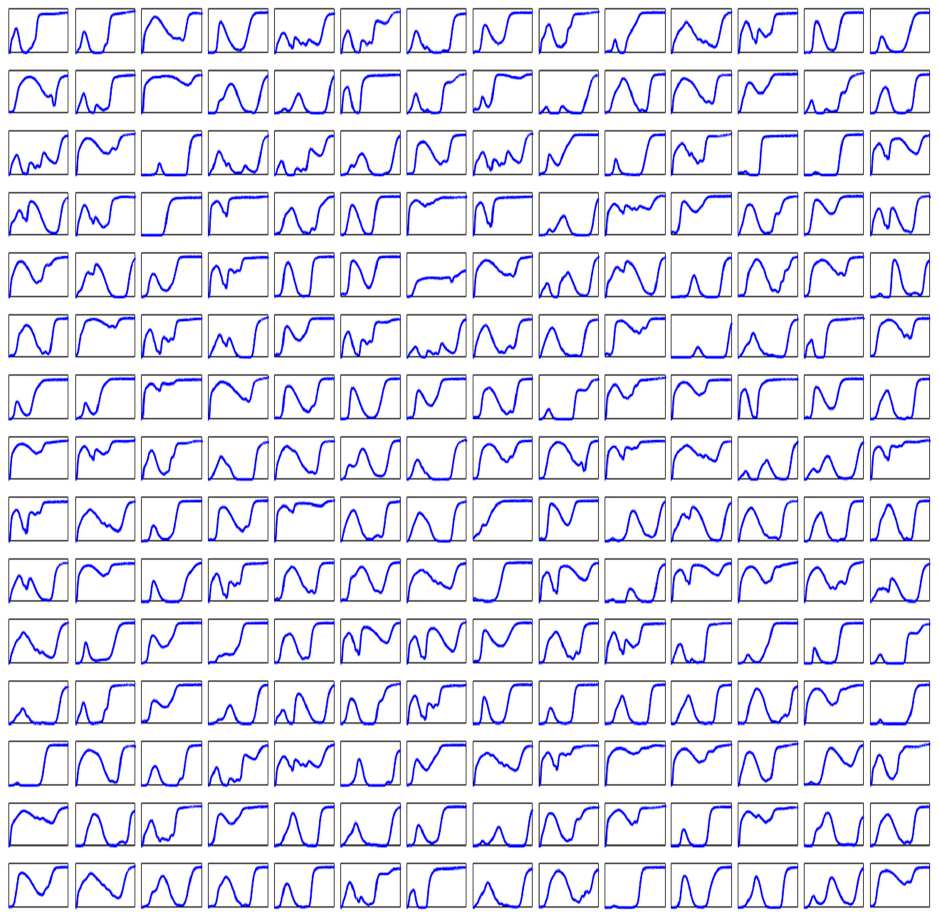
Figure A1. The transmission functions of the 210 filters used in the experiments. The horizontal axis is the wavelength (nm) ranging from 300 nm to 800 nm, the vertical axis represents the transmittance.